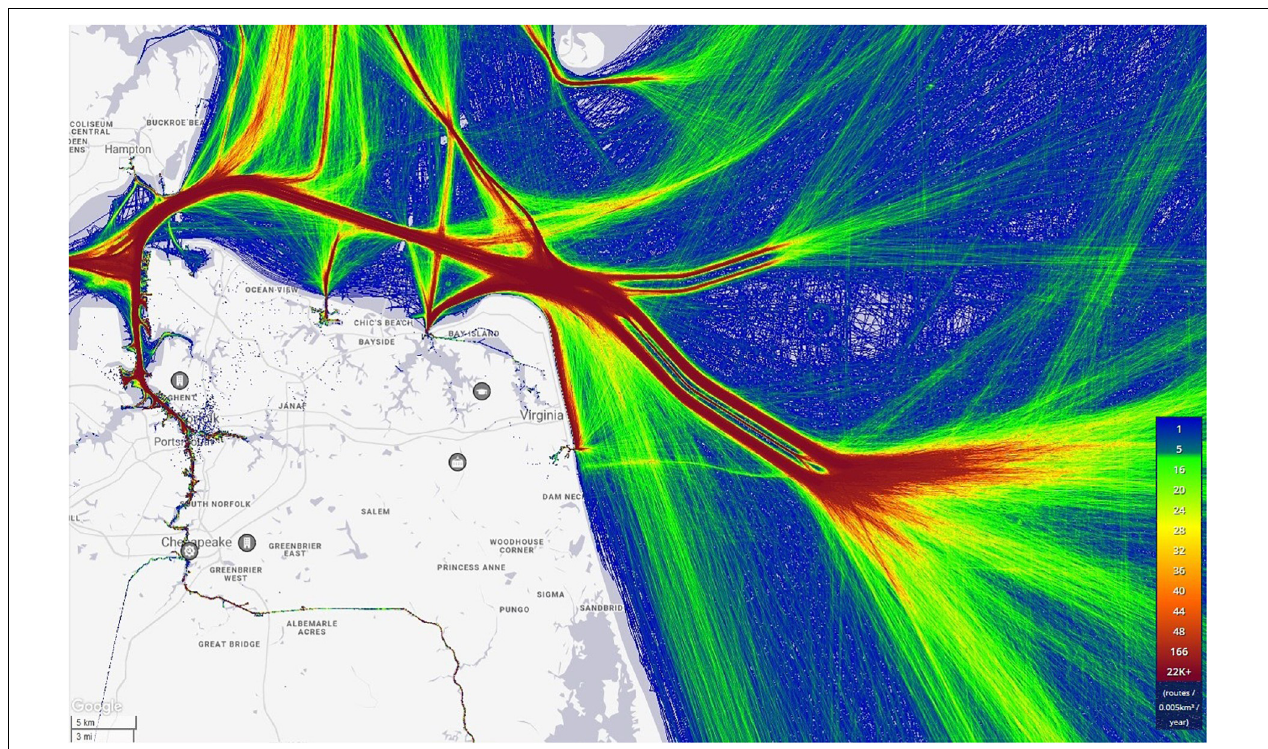
FIGURE 2 | Heat map showing vessel traffic movement in and out of the Chesapeake Bay for the year 2016. The red color indicates the highest density of vessel traffic. Yellow indicates a moderate volume of vessel traffic, and blue indicates the lowest density of vessel traffic. Image provided by